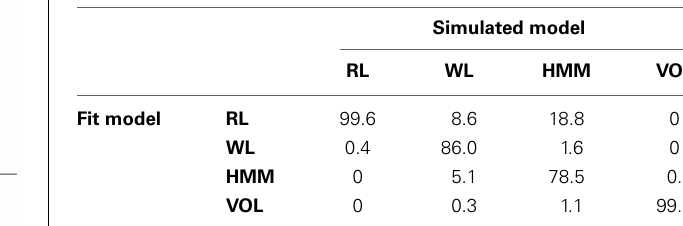
Table 2 | Percentage of best fit models to simulations using each of the